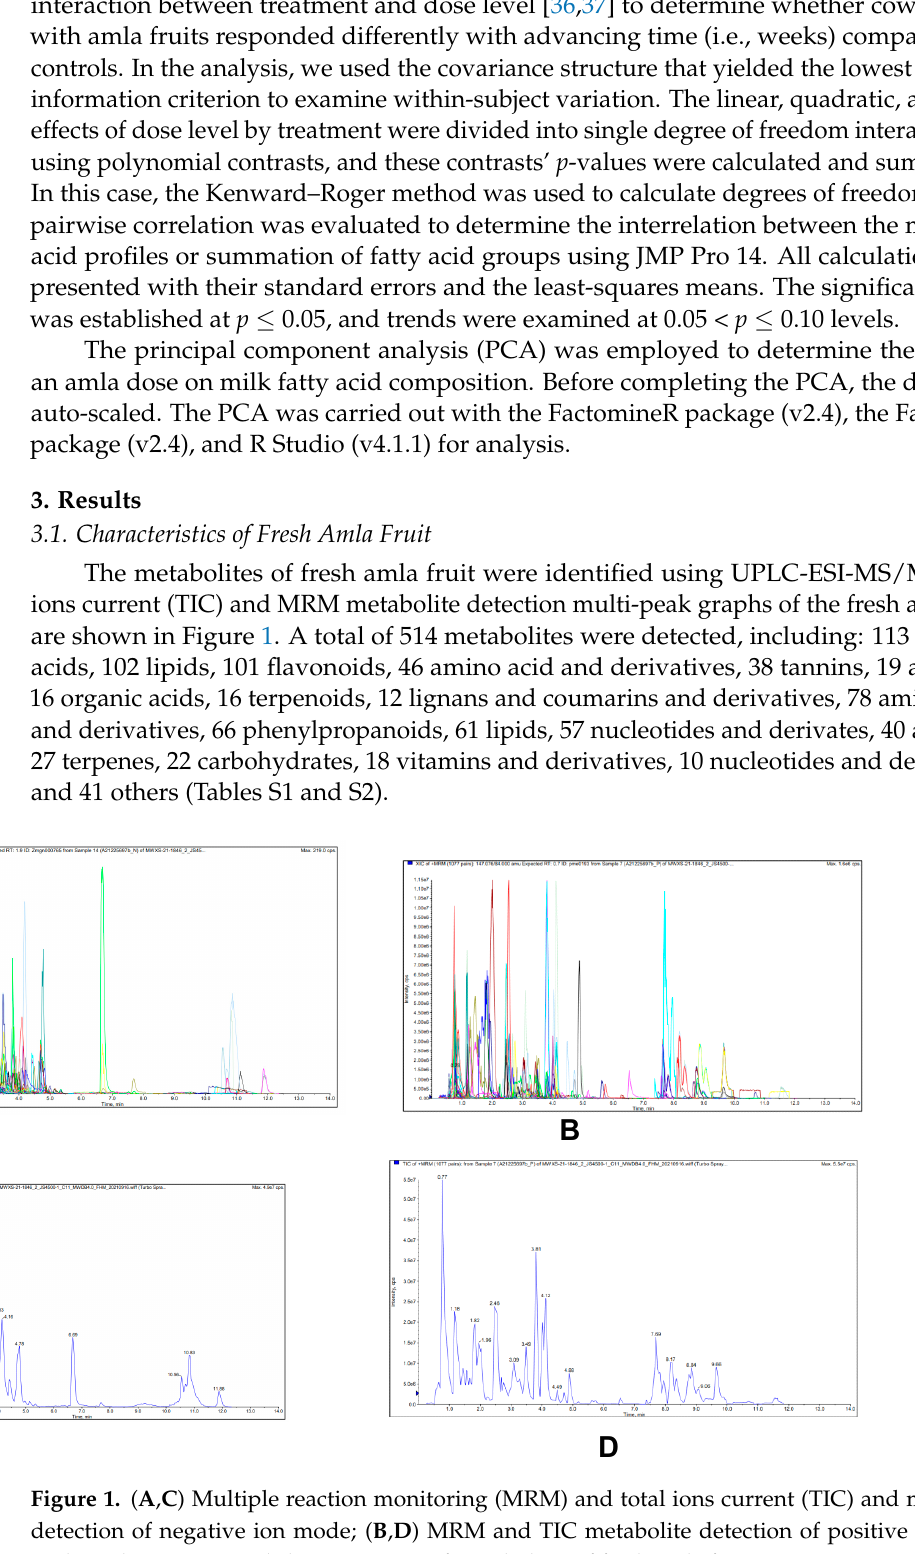
Figure 2. Classification of detected metabolites in fresh amla ( Phyllanthus emblica ) fruit. 3.2. Milk Fatty Acid Profiles The fresh amla fruit supplementation had a noticeable effect on the fatty acid (FA) profile of milk, and its effects on the composition of milk fat (g/100 g of total FA) are shown in Table 4. The contents of the C 10:0 and C 15:0 fatty acids increased in a cubic fashion ( p < 0.001, 0.03, respectively) and a quadratic manner ( p < 0.01, 0.05, respectively) with increas- ing doses of fresh amla fruit. Compared with controls, fat milk profiles increased a little at 200 g/day, decreased sharply when the dosage increased to 400 g/day, and then in- creased dramatically when the dose increased to 600 g/day FAF. The milk FA profiles of